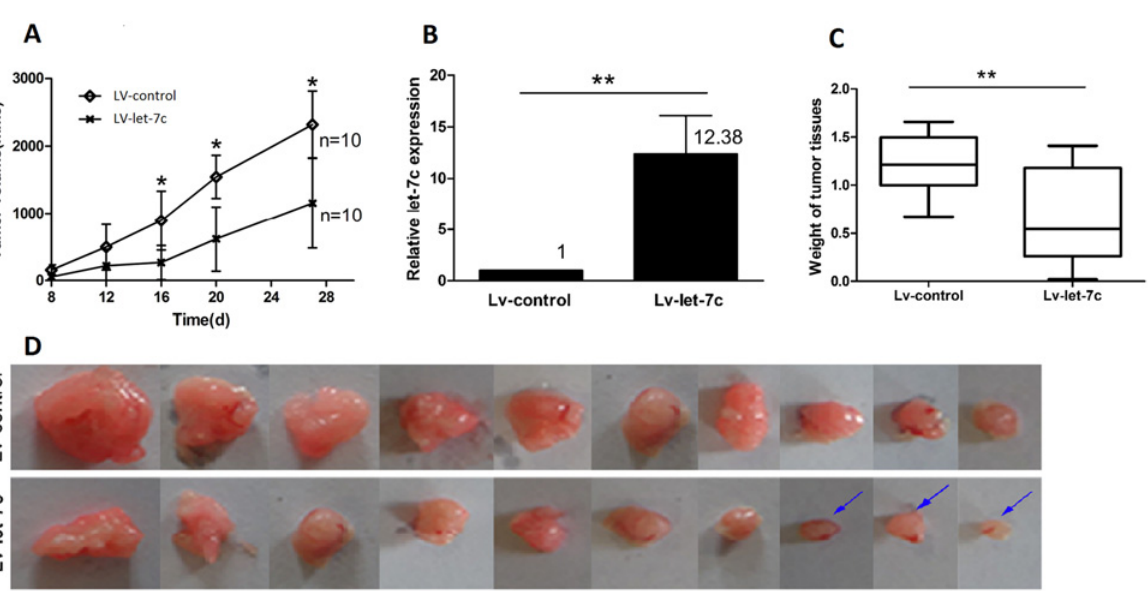
Fig 4. pLenO-RFP-Let-7c inhibits tumor growth in a xenograft mouse model of HCC in vivo. (A) Effects of pLenO-RFP-let-7c (Lv-let-7c) and pLenO-RFP (Lv-control, negative control) in the xenograft mouse model are shown. Data are shown as the mean ± S.D. The statistical difference was analyzed by the two-sample t test. (B) qRT-PCR assays of mature let-7c expression in tissues of the Lv-let-7c and Lv-control group. (C) Weight of tumors of mice in the Lv-let-7c and Lv-control groups. Data are shown as the mean ± S.D. The statistical difference was analyzed by the two-sample t test. (D) Photographs of tumors are presented. The three smallest tumors in the Lv-let-7c group are indicated by blue arrows.